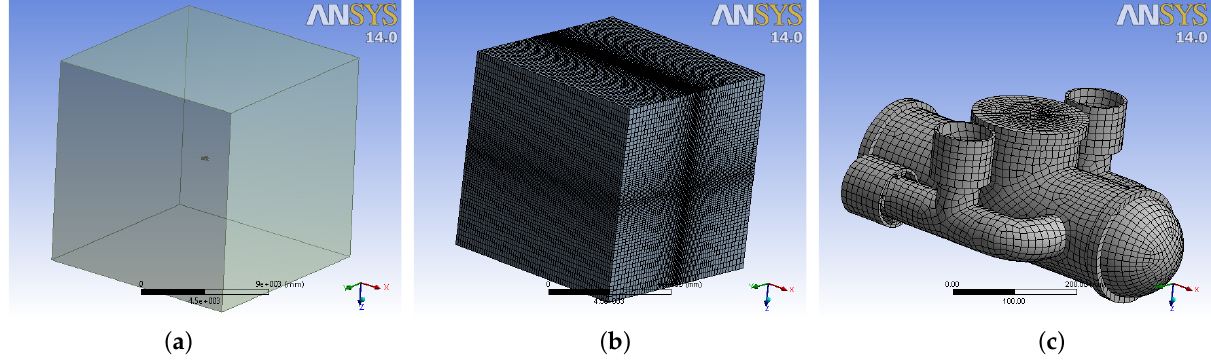
Figure 2. Mini-AUV in ANSYS CFX environment: ( a ) Vehicle and fluid domain. ( b ) Fluid mesh. ( c ) Vehicle mesh.